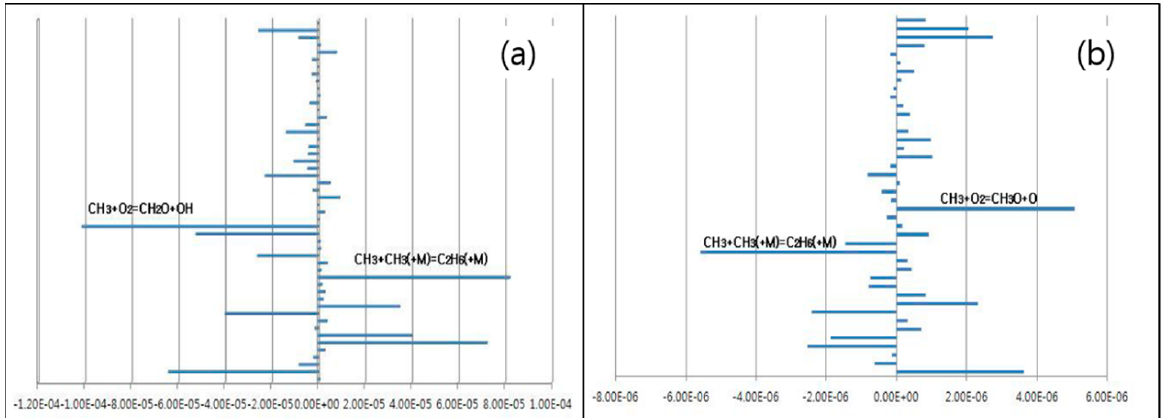
Figure 6. Sensitivity coefficients of ( a ) NO x and ( b ) N 2 O in CH 4 SNCR reactions (NO = 900 ppm, NO 2 = 100 ppm, O 2 = 7 vol%, CH 4 NSR = 2).